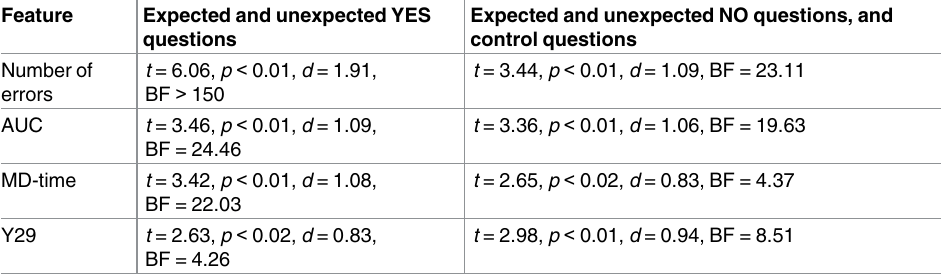
Table 9. Statistics for questions when the liars responded truthfully and for questions when the liars responded falsely.